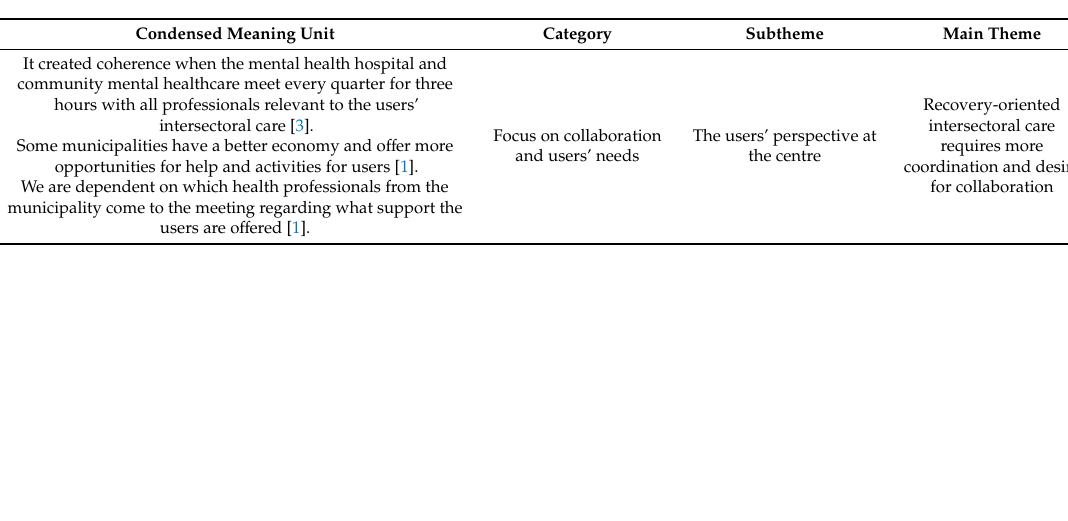
Table 3. Condensed meaning units, categories, subthemes, and themes perceived by health